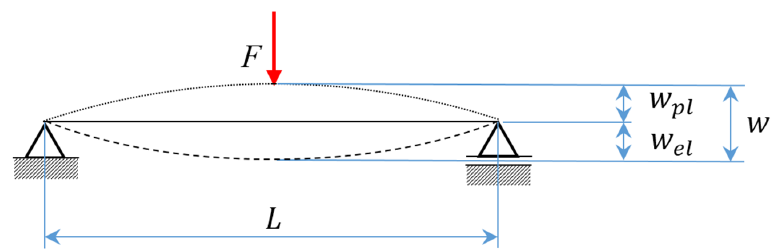
Figure 1. A scheme of a three-point bending case.